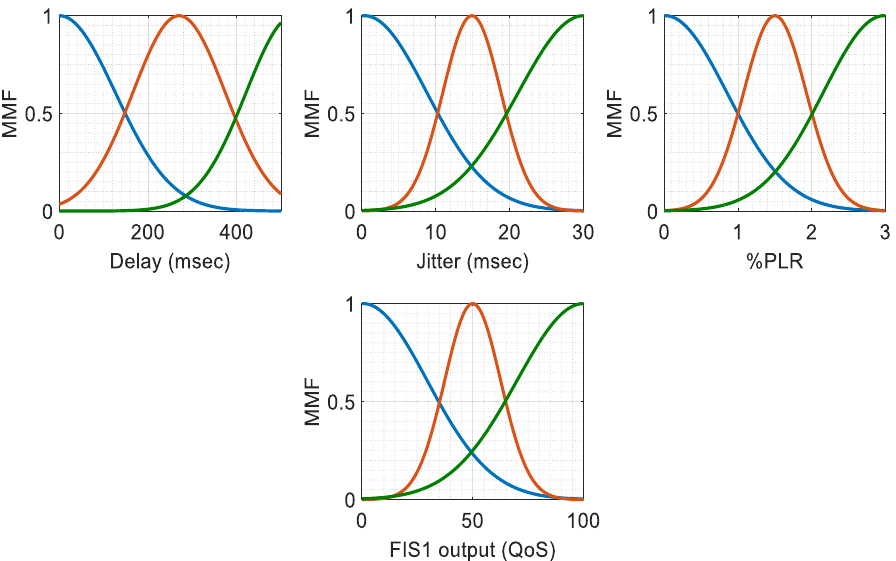
Figure 4. Membership functions (MMF) for FIS1: Inputs (top three figures) and output (bottom figure).